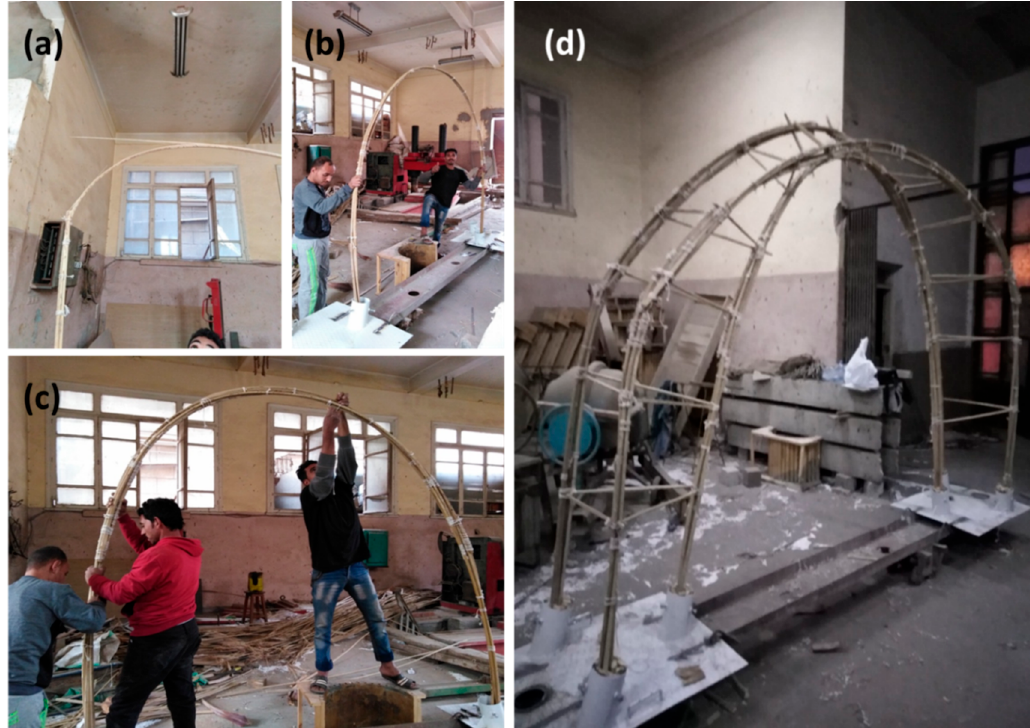
Figure 10. The first attempt in building a specimen. ( a ) Failure in the middle midribs in the first full-length bundle. ( b ) Bending two bundles together. ( c ) The first arch after completion. ( d ) The asymmetrical defect in the completed structure.